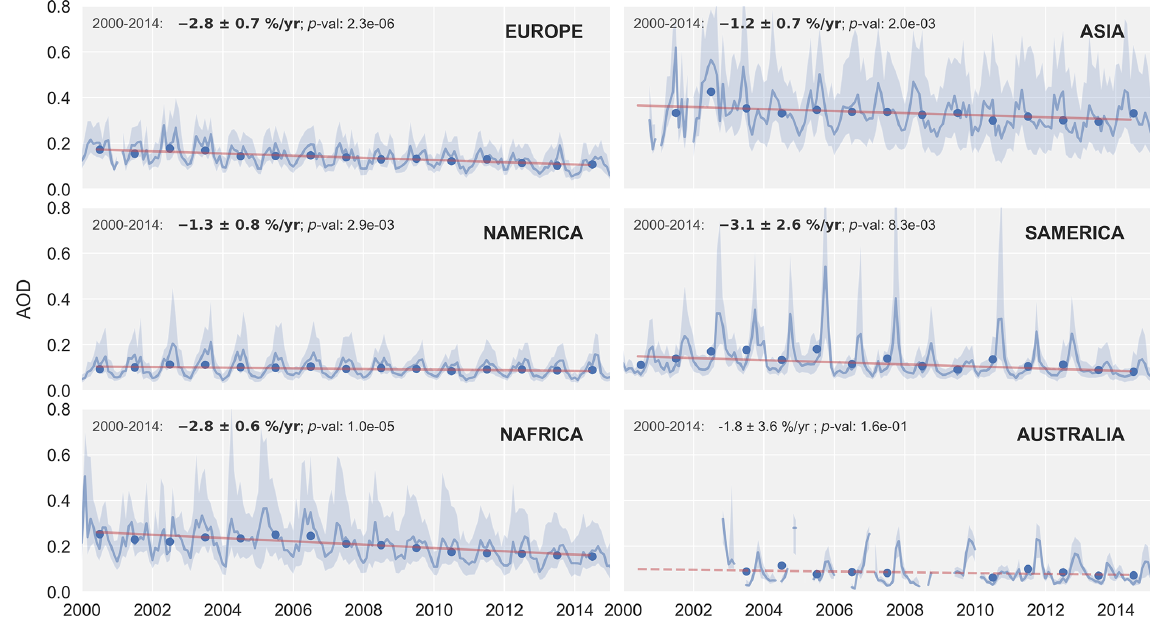
Figure 3. Regional time series of AOD. The dark blue line corresponds to the median, and the light blue envelope is bound by the first and third quartiles of all valid points at the corresponding month, respectively. The blue dots correspond to the yearly averages which are used to compute the linear trend. The latter is displayed as a continuous line when the trend is significant and as a dashed line when it is not. Trend values, an error estimate and a significance value are given in each